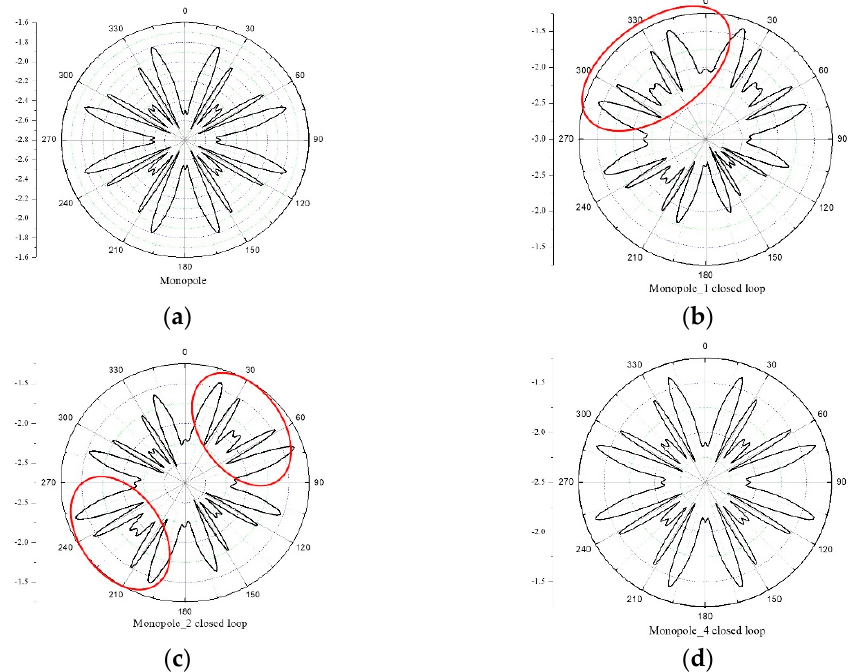
Figure 4. Radiated beam patterns obtained from ( a ) Monopole-only WAVE antenna; ( b ) Single; ( c ) Dual; and ( d ) Quadruple closed-loop devices with monopole WAVE antenna on the 400 mm ground. Red circles denote the region where gain was improved by introducing closed-loop devices.